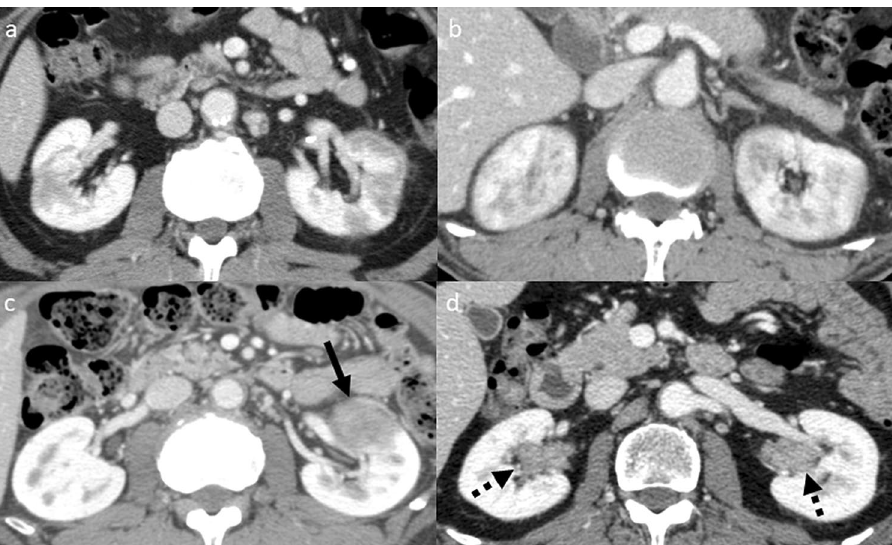
Figure 1. Characteristic findings of IgG4-related kidney disease on contrast-enhanced CT. (a) Multiple hypodense lesions. (b) Diffuse renal swelling. (c) A solitary hypodense lesion (arrow). (d) Diffuse thickening of the renal pelvis wall (broken